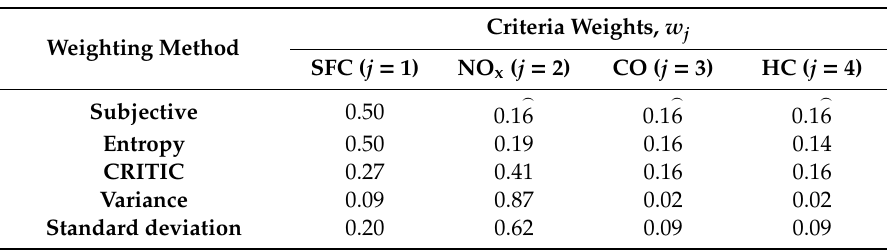
Table 4. Criteria weights according to the subjective, entropy, CRITIC, variance, and standard deviation weighting methods.